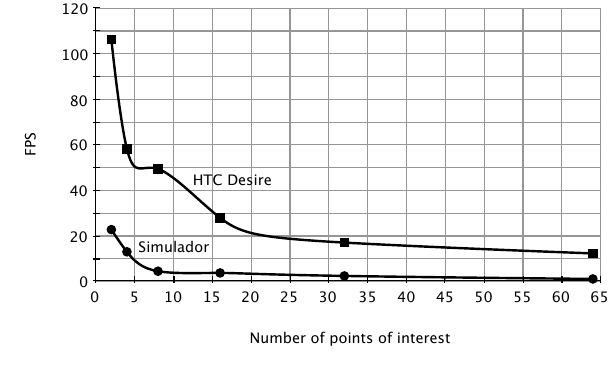
Fig. 8. Graphical interface’s